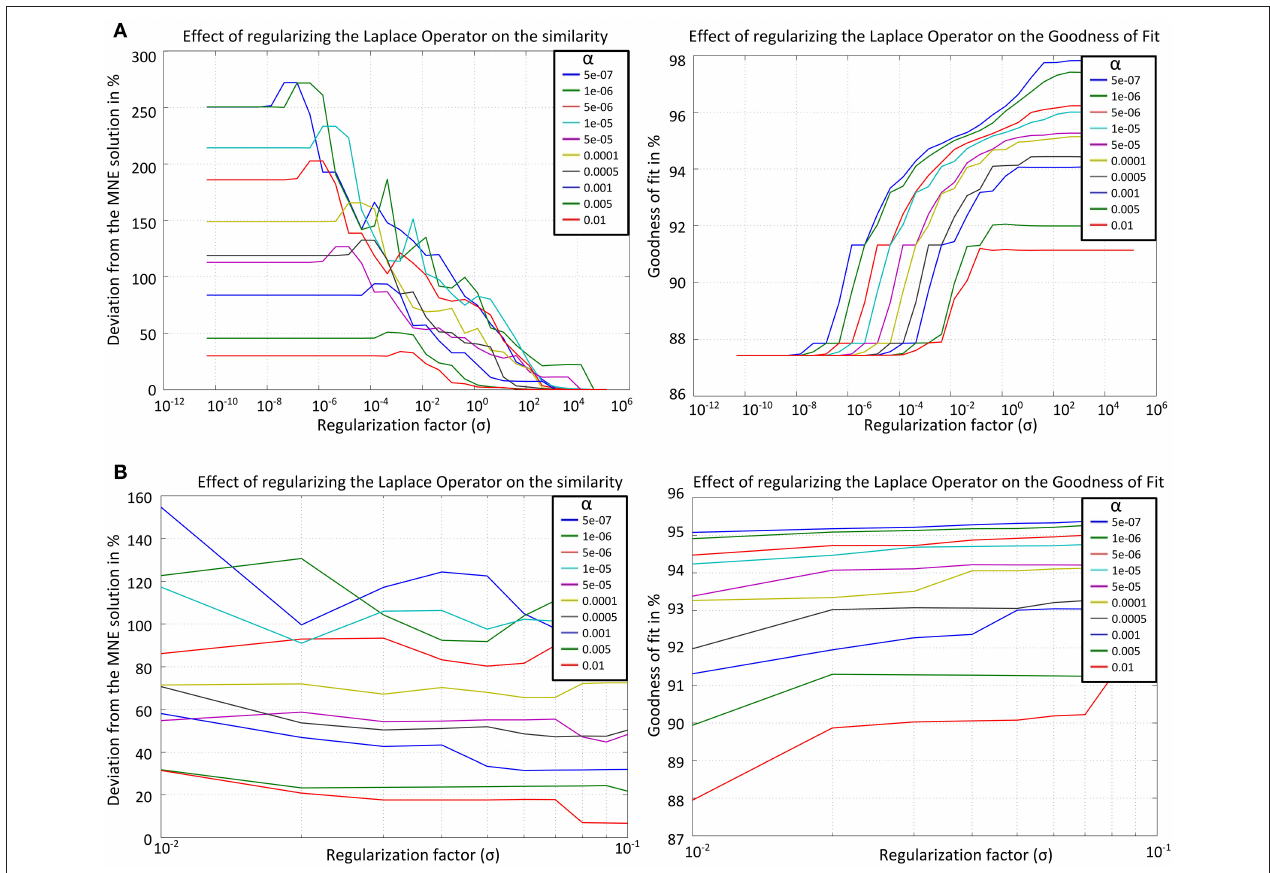
FIGURE 3 | Results for the similarity to the solution without Laplacian (left) and the GOF (right) for the graph Laplacian applied on the simplified cortical form over (A) the whole range of σ (top row), (B) σ in the interval [10 − 2 10 − 1 ] (bottom row). The curves computed for different α values are denoted by different